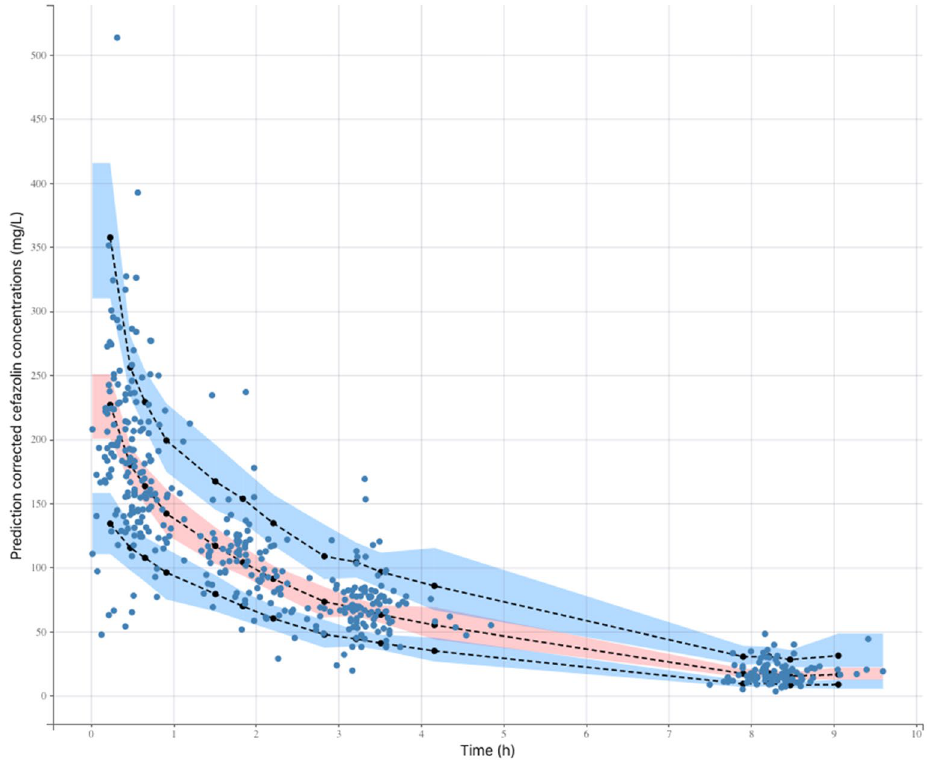
Figure 1. Prediction-corrected visual predictive check of the pharmacokinetic model. The 5th, 50th and 95th prediction intervals from the simulated concentrations of cefazolin are plotted against time, with the observed data superimposed. Blue and orange shaded areas are confidence interval of the prediction interval (dashed